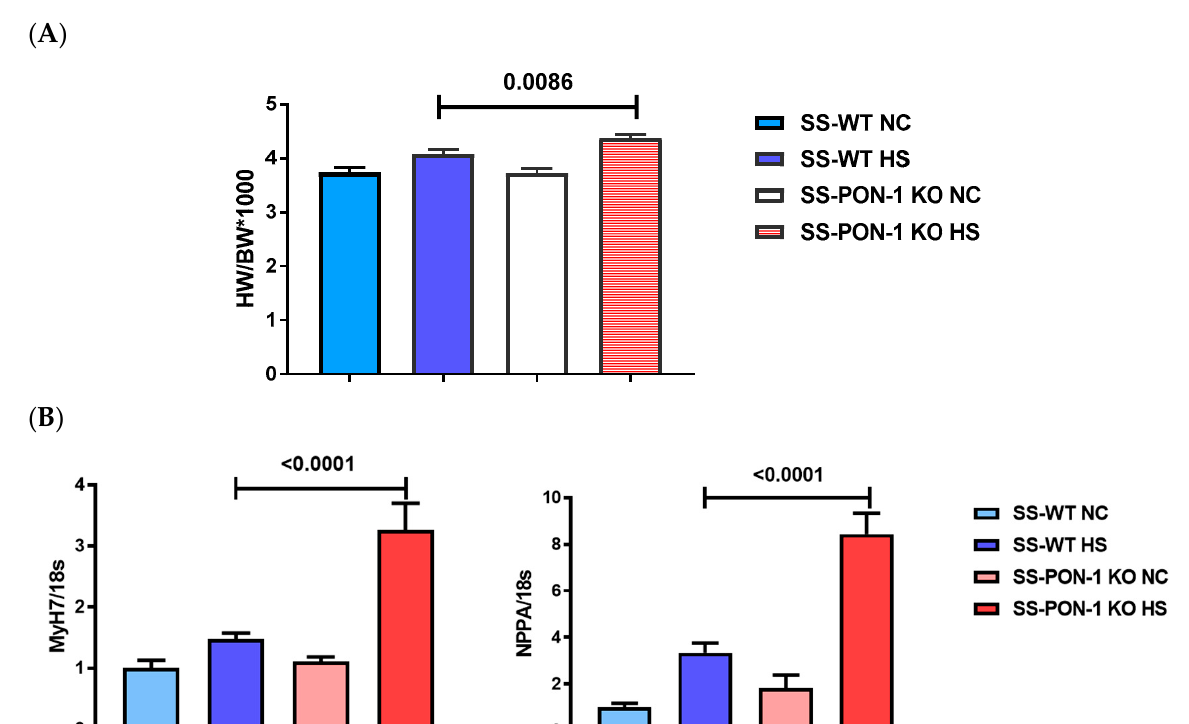
Figure 3. Targeted mutation of paraoxonase-1 leads to increased cardiac hypertrophy in a hyper- tensive renal disease model. ( A ) SS-PON-1 KO on high-salt diet demonstrate significant increase in heart-weight-to-body-weight ratio compared to SS-WT rats; ( B ) SS-PON-1 KO on high-salt diet demonstrate significant increase in cardiac hypertrophic gene expression compared to SS-WT rats ( N = 8). Data are presented as the mean ± standard error of the mean. One-way ANOVA and post hoc multiple comparison tests were used to assess statistically significant differences between the